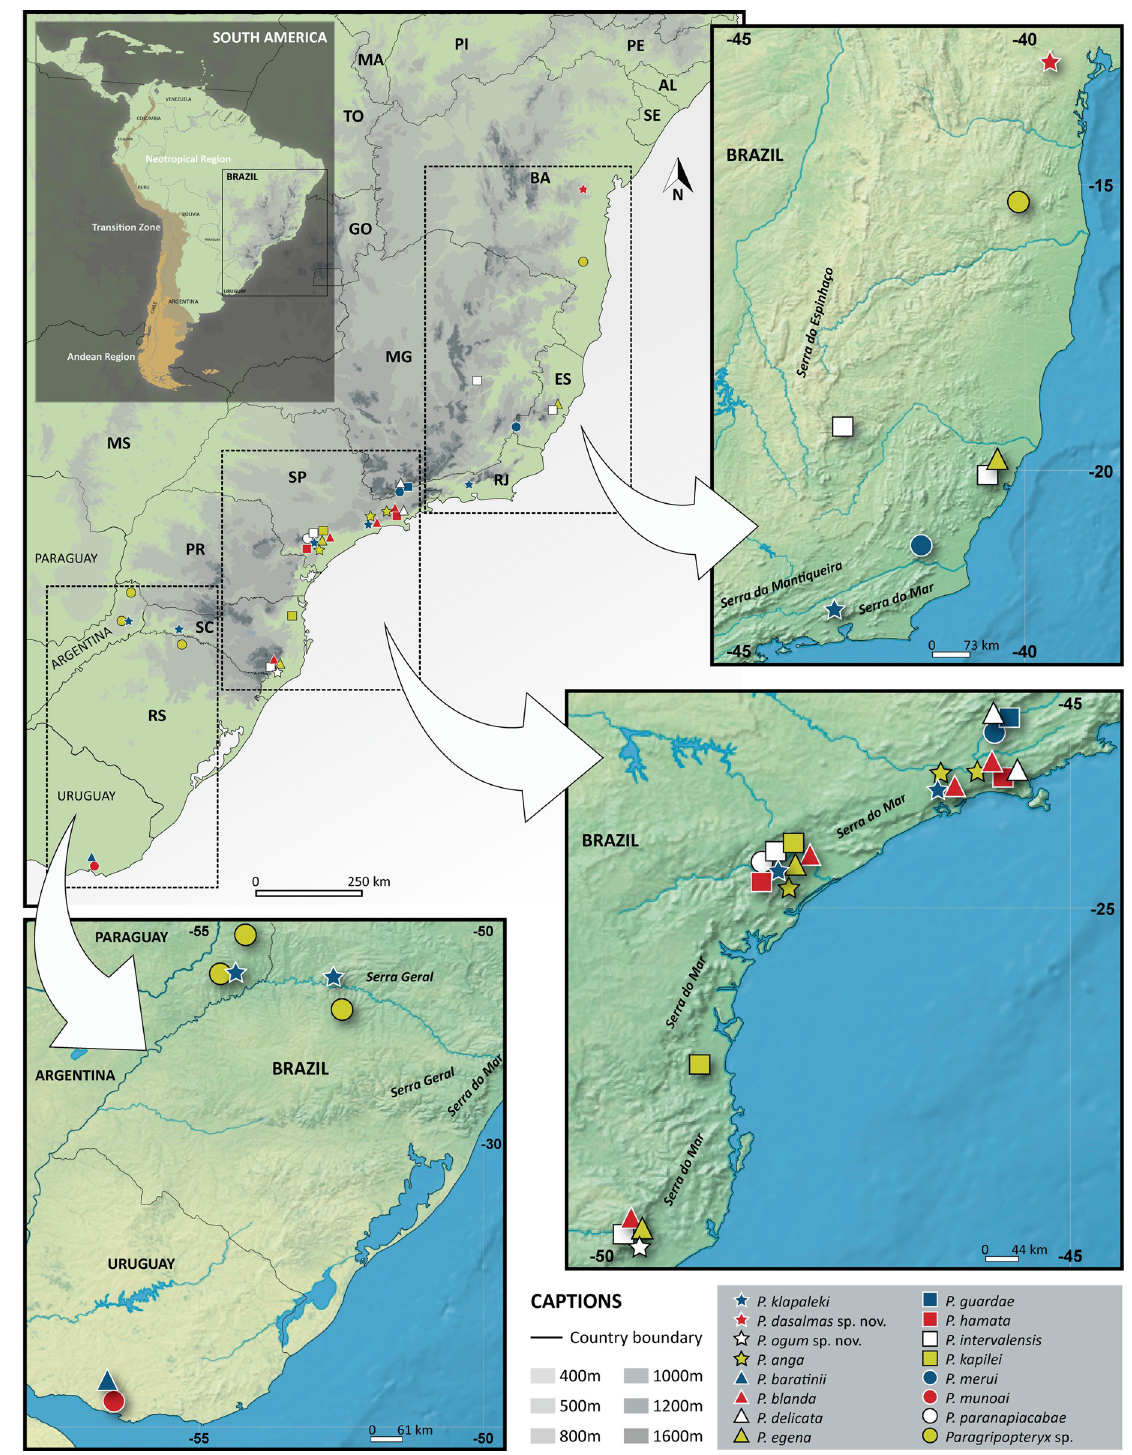
Fig 3. Distribution map. Map of South America highlighting the Neotropical Region (in light green) with records of Paragripopteryx along the Brazilian coastal mountains, from northeastern Bahia to southeastern and southern Brazil, reaching the Province of Misiones (Argentina), where some specimens were recorded, and the Uruguayan coast, where P . baratinii and P . munoai were sampled. (Reprinted from https://www.simplemappr.net under a CC BY license, with permission from David Shorthouse, original copyright 2021.).